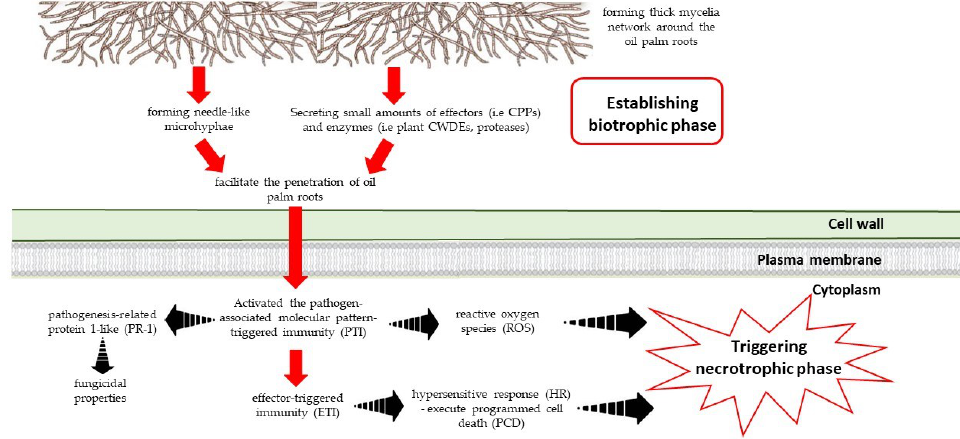
Figure 3. The interaction between fungal pathogen ( G. boninense ) and the plant (oil palm root).